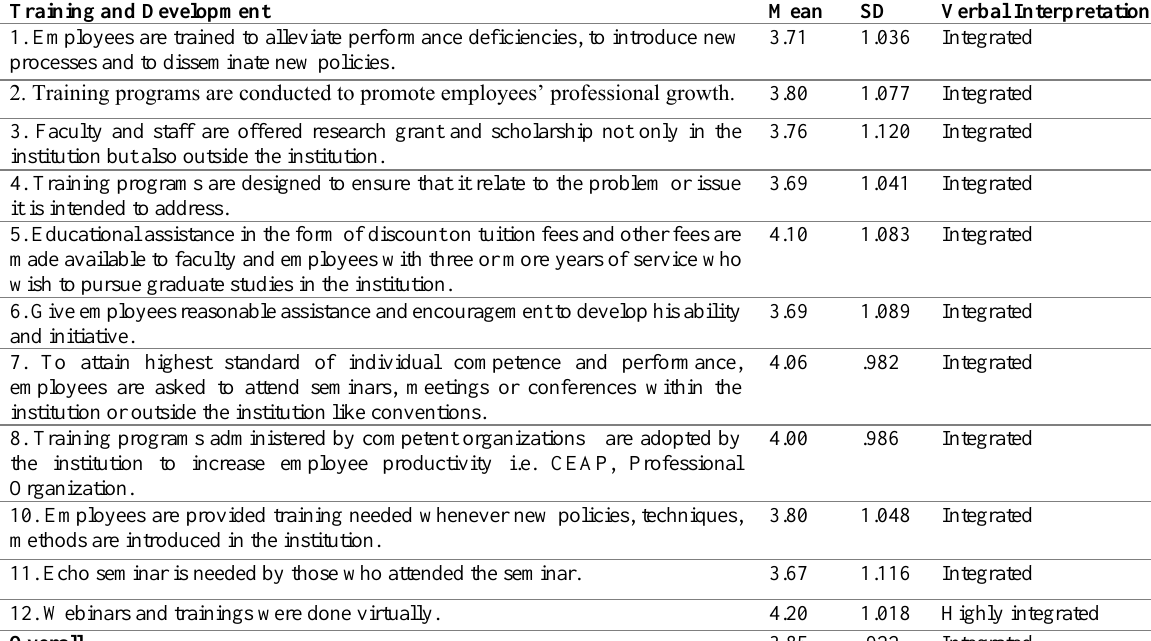
Table 5: Extent of Integration of Commitment to the Training and Development as Perceived by Respondents Training and Development